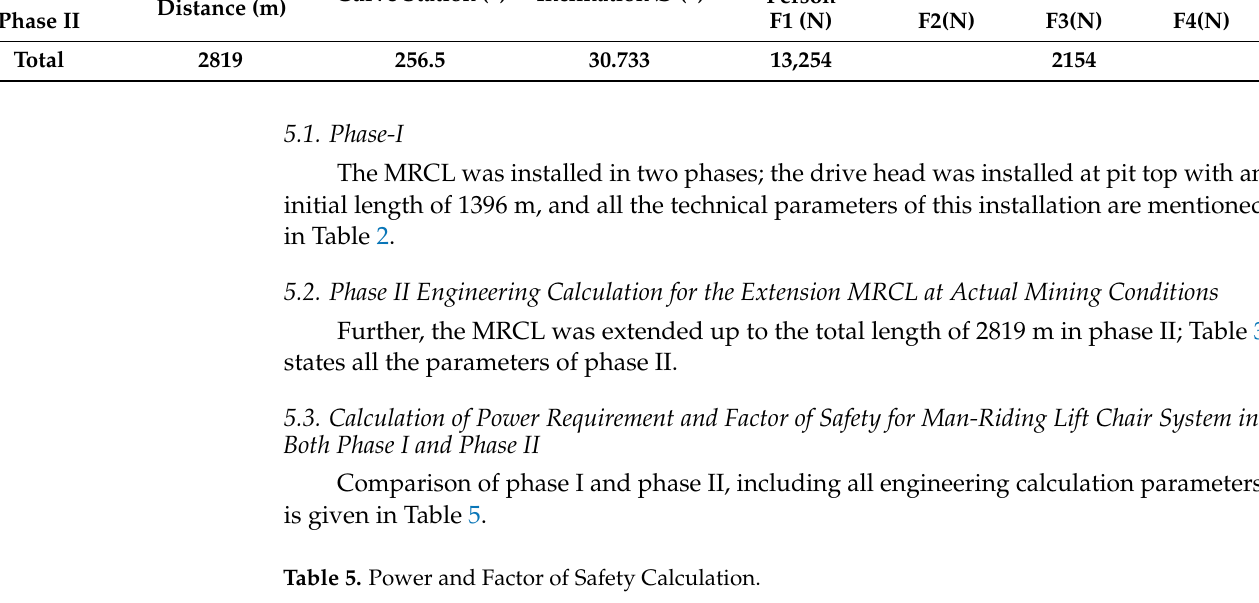
Table 5. Power and Factor of Safety